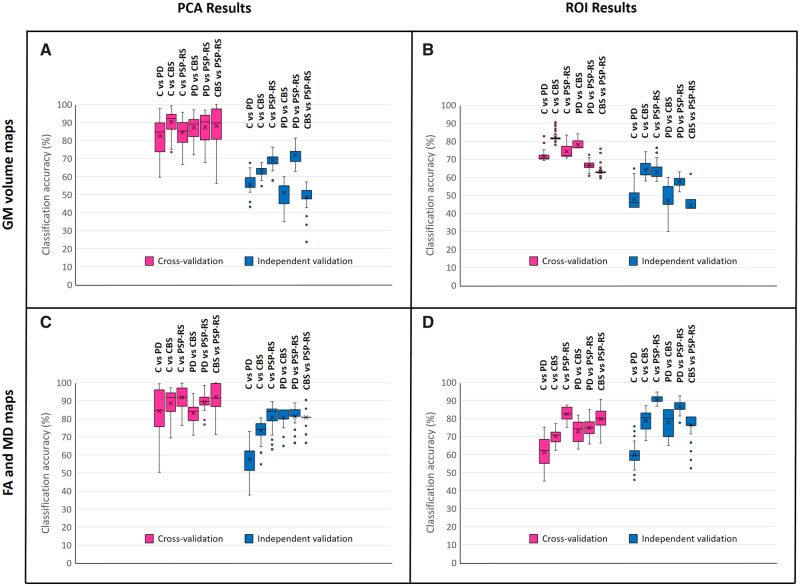

Cross-validation versus independent validation. Comparison between cross-validation (magenta) and independent validation (blue) results. The range of classification accuracies presented for each pairwise comparison and combination of methodological variables corresponds to the results obtained as different numbers of features are included in the statistical model. (A) Results obtained when PCA is used for feature extraction, with GM volumes maps as feature type. (B) Results obtained when ROIs are used for feature extraction, with GM volumes maps as feature type. (C) Results obtained when PCA is used for feature extraction, with FA and MD maps as feature type. (B) Results obtained when ROIs are used for feature extraction, with FA and MD maps as feature type.